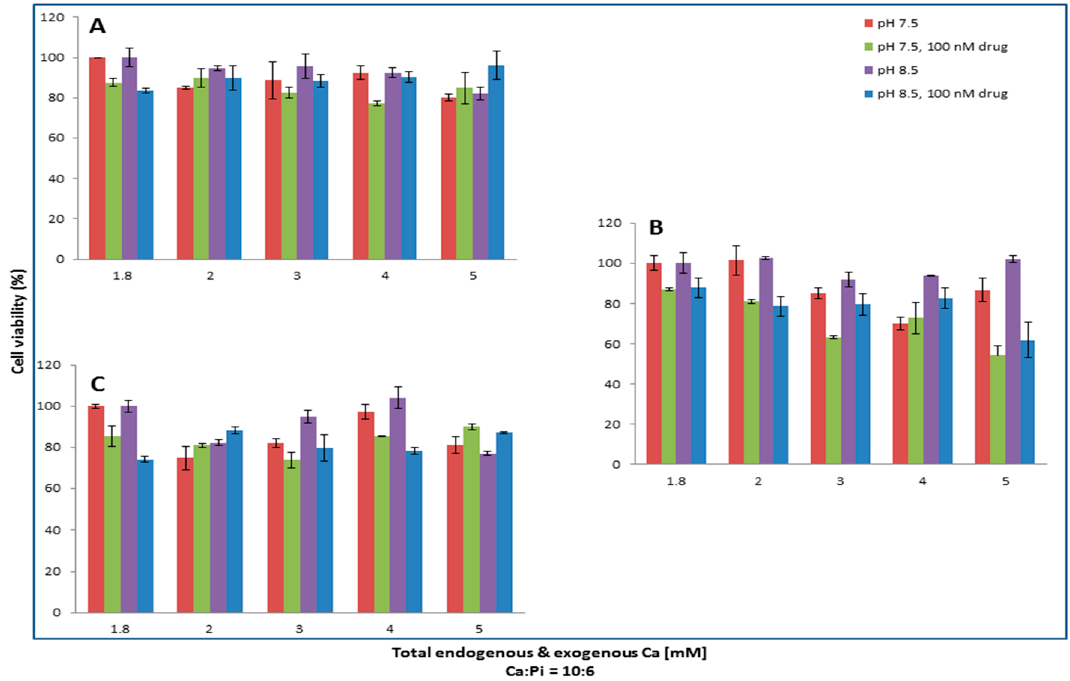
Figure 8. Apatite/drug was formed with 100 nM of Pac ( A ), Mito ( B ), and Topo ( C ) in three different pHs (6.5, 7.5, and 8.5). Various concentrations of total exogenous and endogenous calcium and phosphate were added in 10:6 ratio for apatite formation. MCF-7 cells were seeded one day earlier on 24-well plates at 5 × 10 5 cell/mL and were treated with apatite alone or apatite/drug . After 44 h of treatment cell viability was measured by MTT assay. Values were represented as the mean percentage of cell viability ± SD as compared to media as control for free drug and apatite only in the case of apatite/drug.